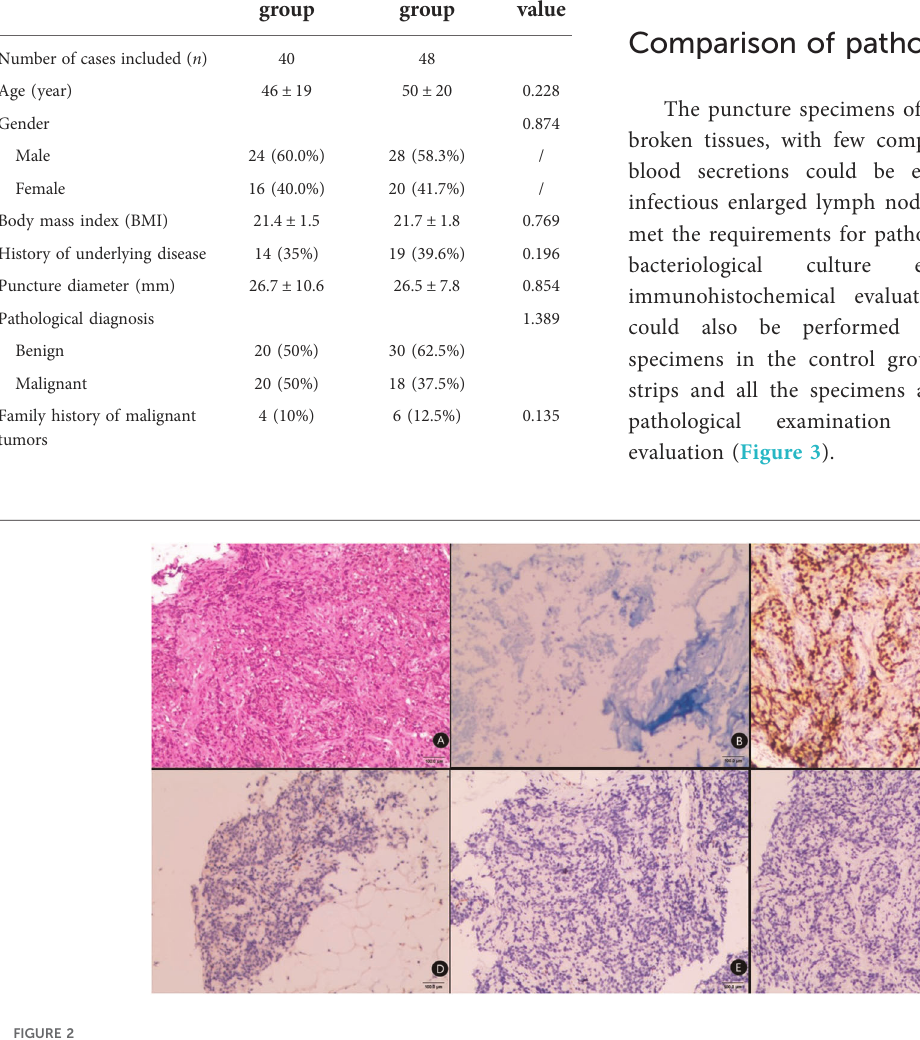
FIGURE 2 Pathological tissue examination of the modi fi ed needle aspiration biopsy specimens. ( A ) Acid-fast staining of the puncture tissue, bar=100 μ m; ( B ) CgA staining of the puncture tissue, bar=100 μ m; ( C ) P40 staining of the puncture tissue, bar=100 μ m; ( D ) HE staining of the puncture tissue, bar=100 μ m; ( E ) CK7 staining of the puncture tissue, bar=100 μ m; ( F ) TTF1 staining of the puncture tissue, bar=100 μ